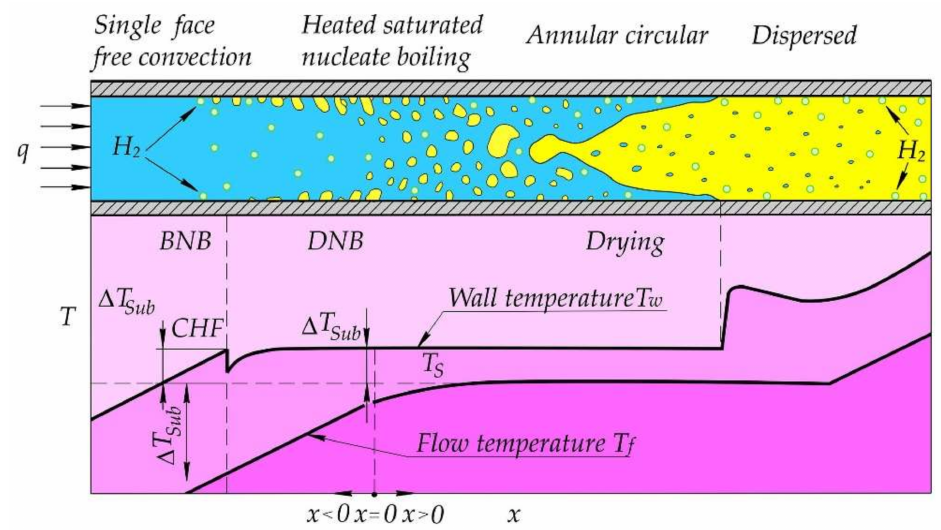
Figure 1. Regularities of the heated liquid parameters’ changes in the channel of the engine’s cylinder head cooling system: BNB and DNB —the beginning of nucleate boiling and its development; CHF —point of critical heat flow; x —mass steam quality